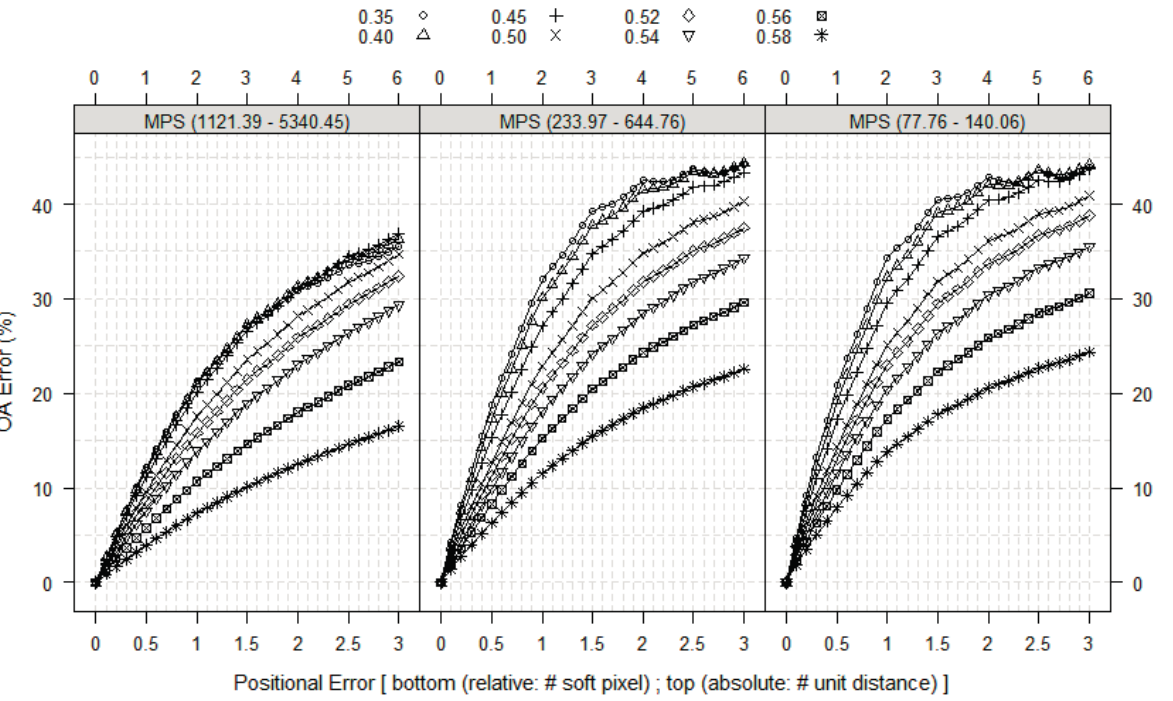
Figure 4. Impact of positional error on OA-error at different landscape characteristics using a spatial resolution of 2 unit